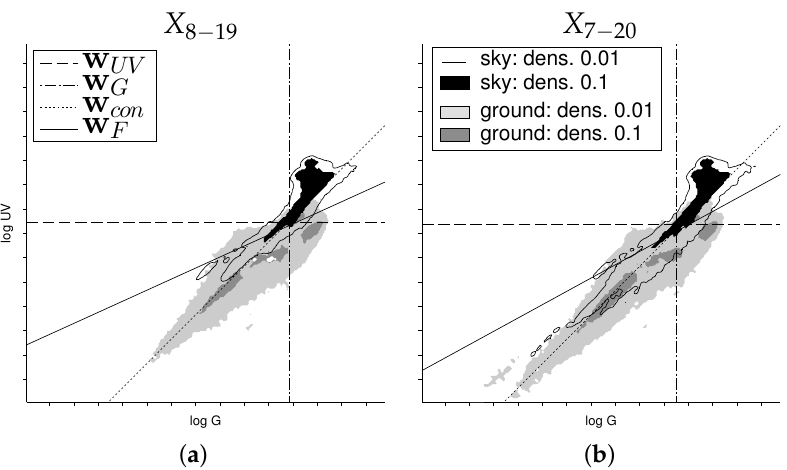
Figure 10. The plot shows the pooled data of all datasets recorded during the daytimes ( a ) 8:00–19:00 and ( b ) 7:00–20:00, where the same number of sample points has been taken from each of the four different datasets presented in Figure 9 (stones, sand, earth, forest/suburban). For details, see Figure